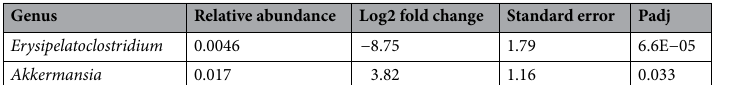
Genus Relative abundance Log2 fold change Standard error